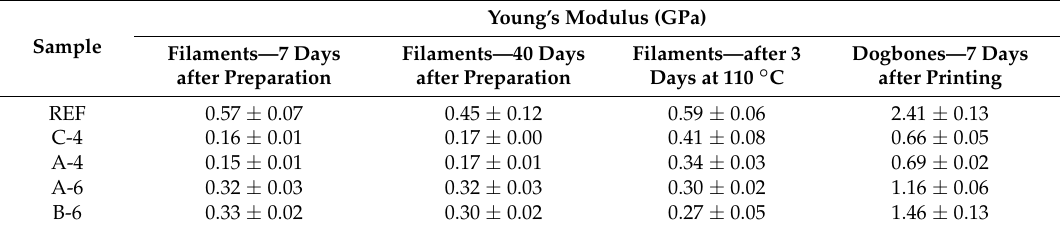
Table 3. Young’s modulus (GPa) of measured PHB/PLA/plasticizer samples and PHB/PLA reference.